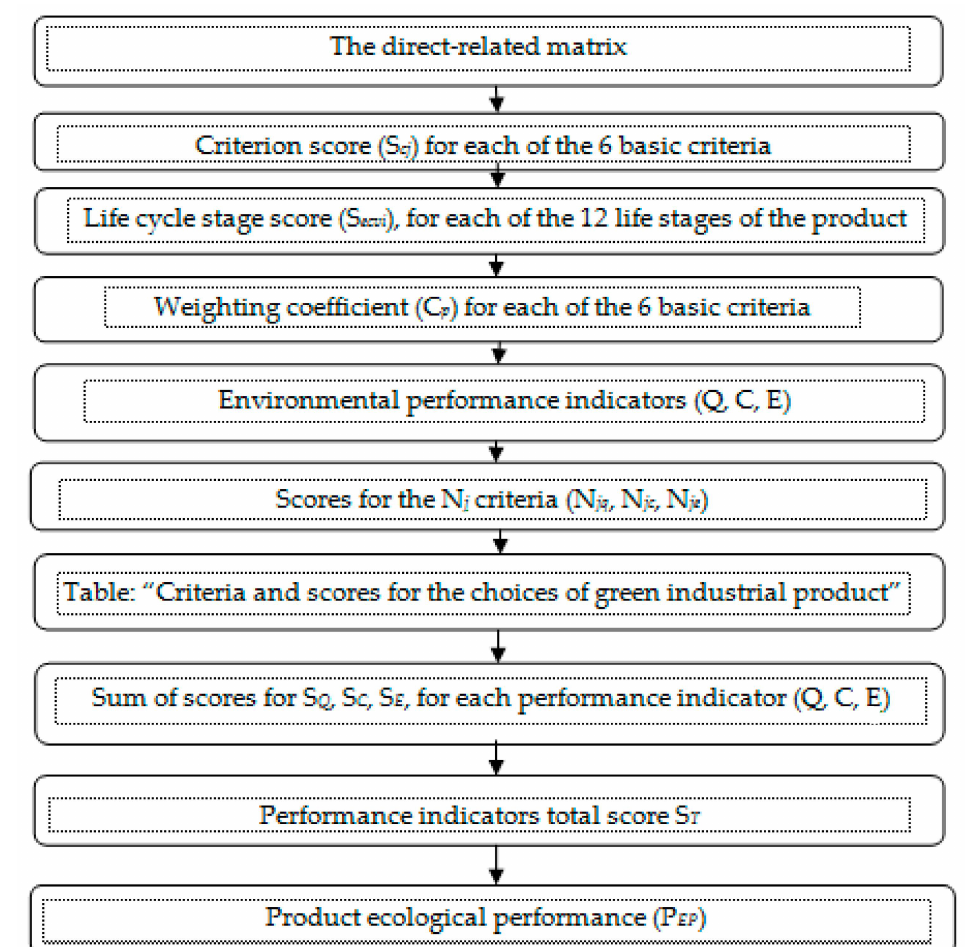
Figure 1. The algorithm for the new proposed eco-friendly method for determination of the ecological performance (P EP ) of the “Tractor truck 18.5 tons” and “Urban Crosstown